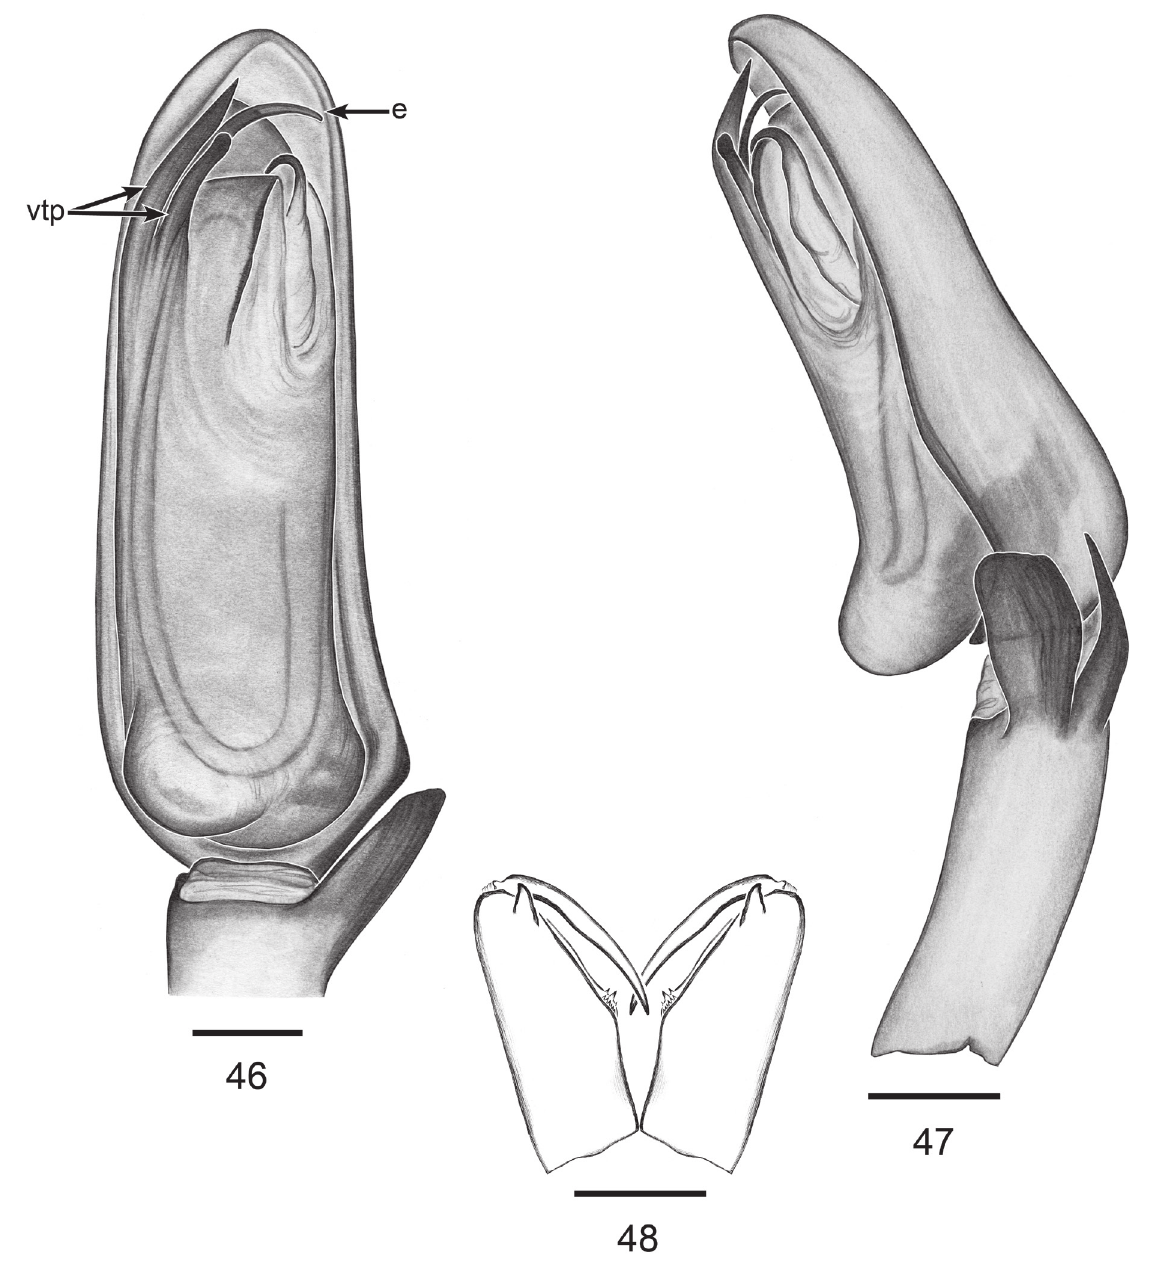
Figs 46–48. Patrera shida sp. nov. 46 . ♂, palp, ventral view. 47 . ♂, palp, retrolateral view. 48 . ♂, chelicerae, posterior view. Scale bars: 46–47 = 0.1 mm; 48 = 0.5